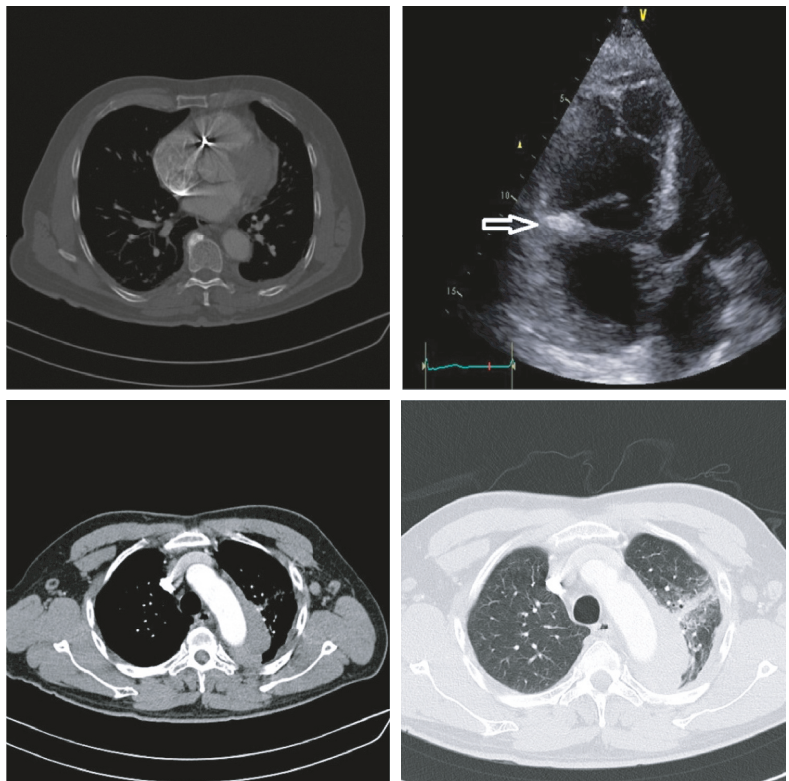
Figure 1: Thoracic CT shows hematoma around the aorta with no wall wound. Echocardiogram shows bullet in the tricuspid valve ring without perforation